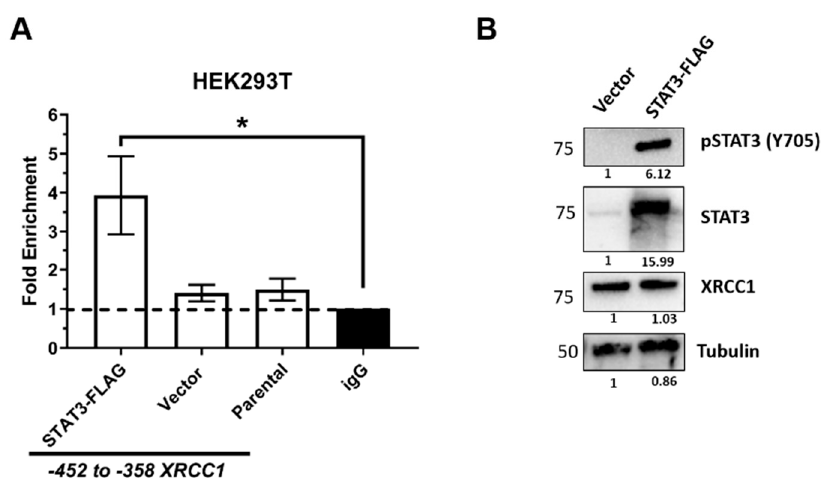
Figure 6. Ectopic overexpression of STAT3 increases STAT3 occupancy within the XRCC1 promoter in HEK293T cells. ( A ) ChIP analysis of STAT3 binding to the -452 to -358 XRCC1 promoter fragment. * p < 0.05 ( B ) Representative immunoblots of phospho-STAT3 (Y705), STAT3 and XRCC1 protein expression following ectopic expression of STAT3-FLAG. α -tubulin is used as a loading control.